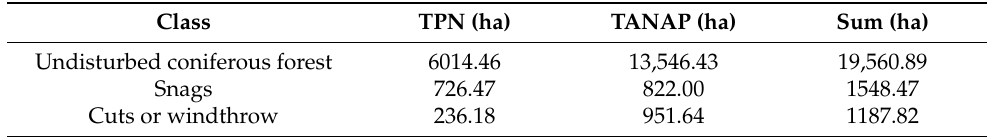
Table 7. Snags and cuts/windthrow class statistics of the Polish (TPN) and Slovak (TANAP) Tatra National Parks. Data presented in hectares. Acquired on the SVM classification based on the 15 remote sensing